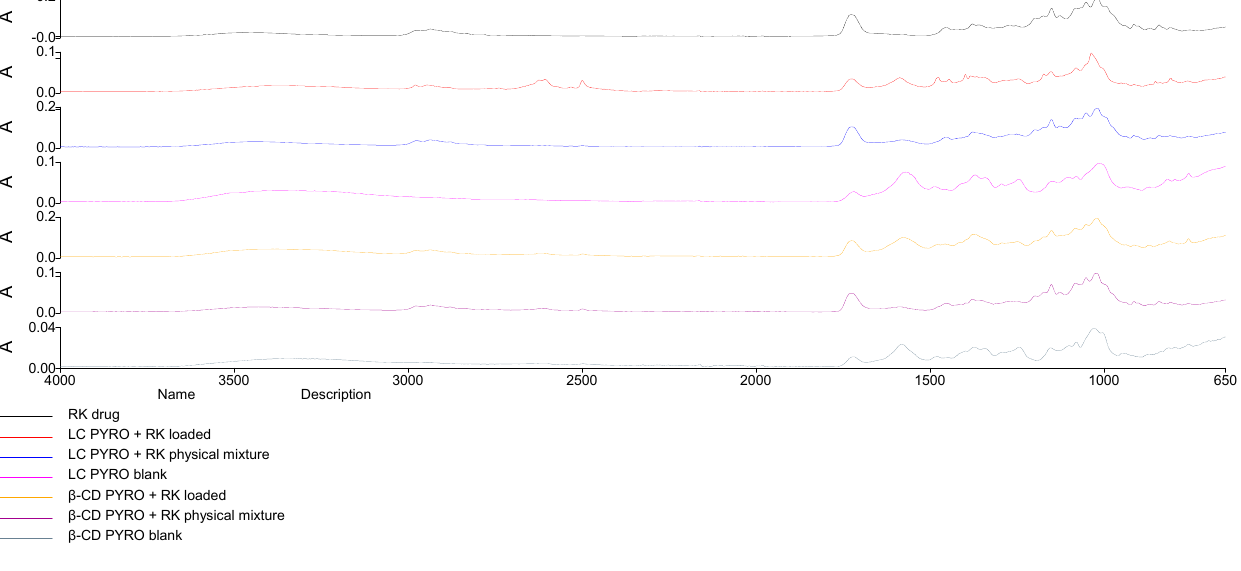
Figure 5. FTIR analysis of RK, blank NSs, physical mixtures, and loaded NSs indicated the principal differences.